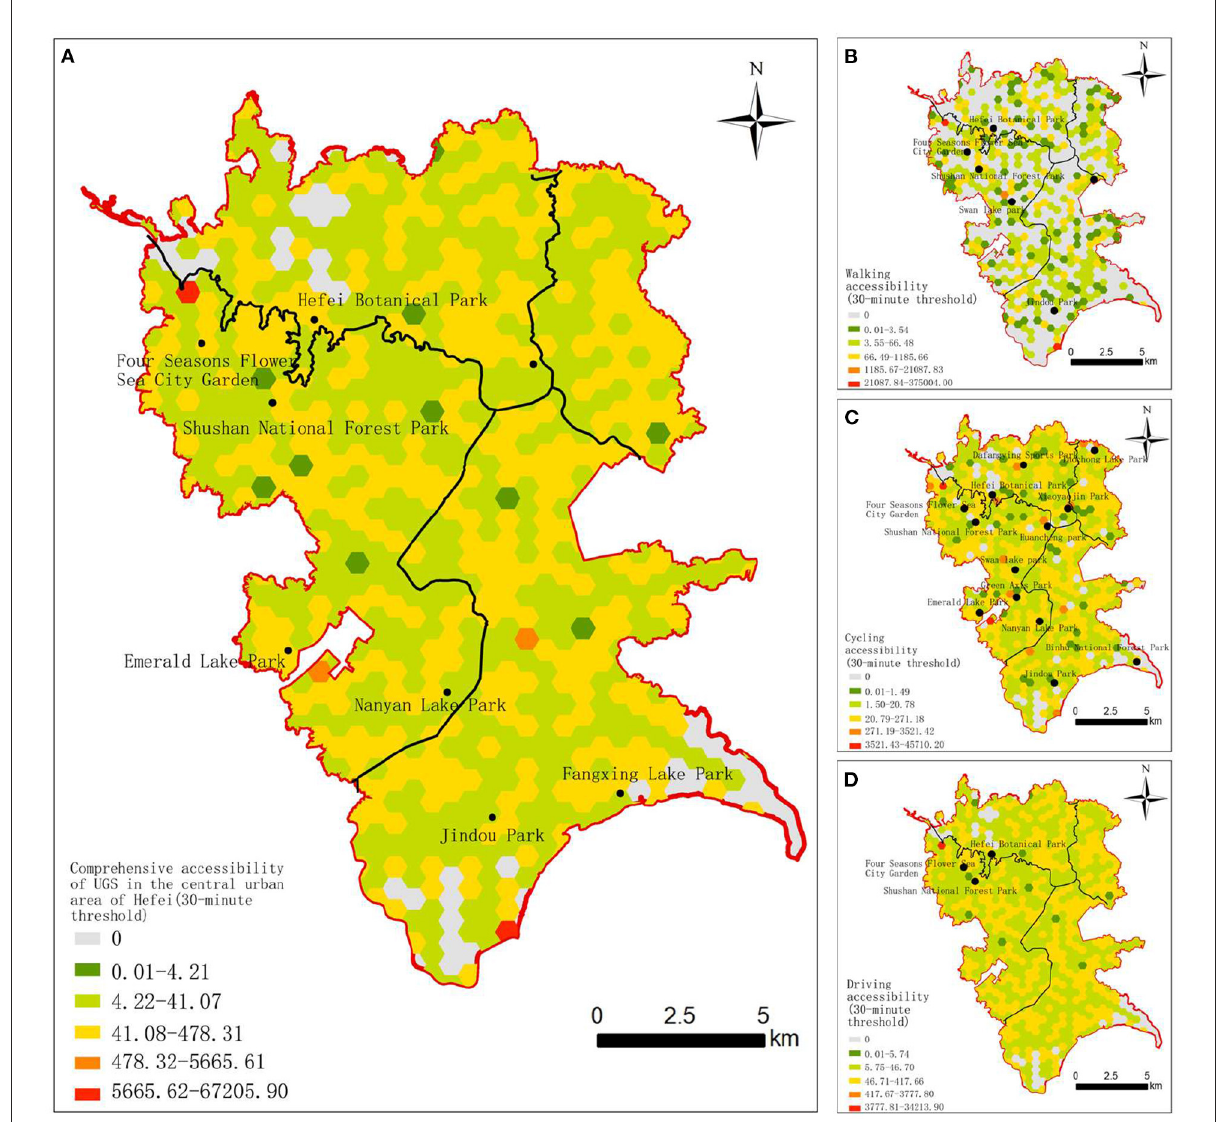
FIGURE5 Accessibility of UGS in the central urban area of Hefei at the 30-min threshold. (A) Comprehensive accessibility. (B) Walking accessibility. (C) Cycling accessibility. (D) Driving